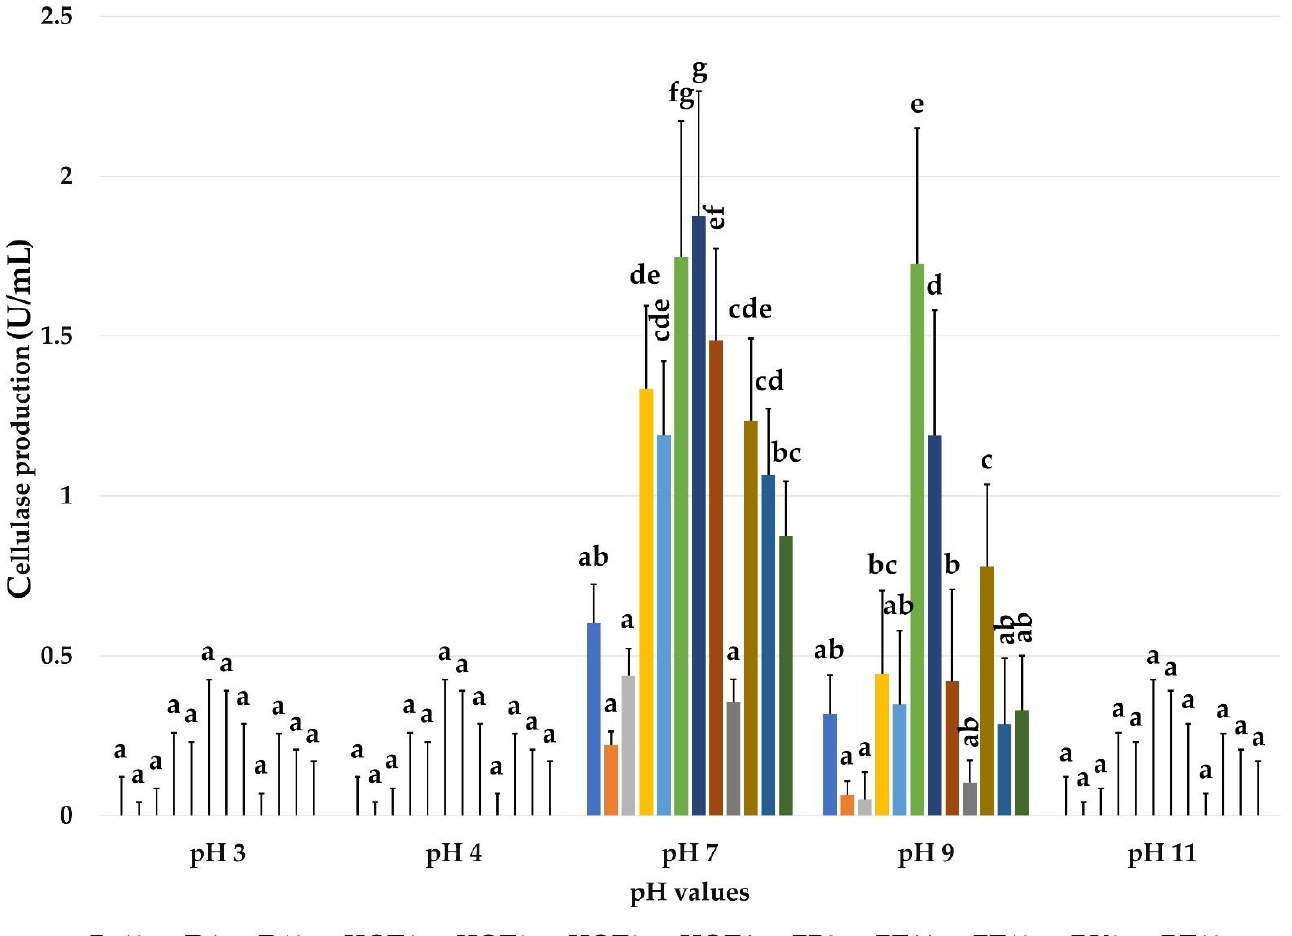
Figure 4. Effect of pH on the production of CMCase in CMC broth (1%) of the 12 isolates tested. The results are expressed as the mean-standard error of the values of the enzymatic units in duplicate. The effects of acid and alkaline concentrations corresponding to each treatment and not sharing the same letters are significantly different according to Tukey ’ s post hoc HSD test.